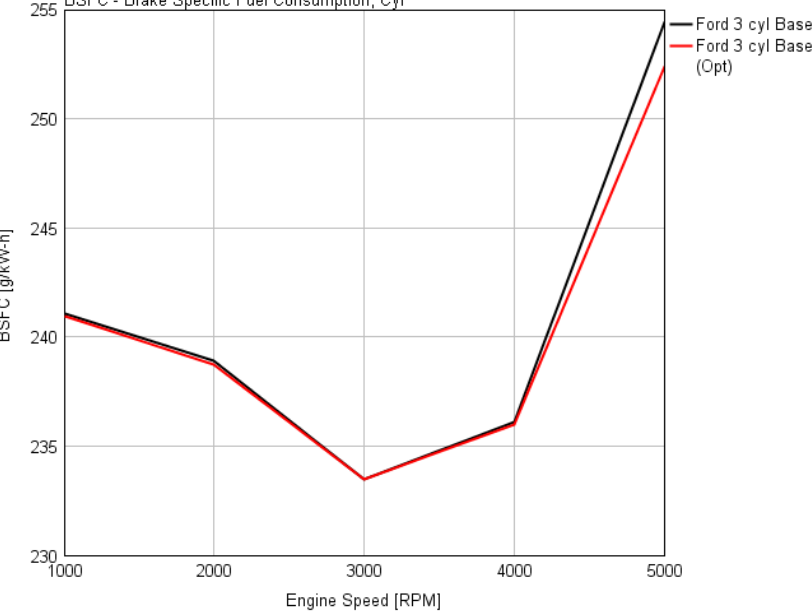
Figure 17. BSFC graphs for the initial and optimized baseline models.